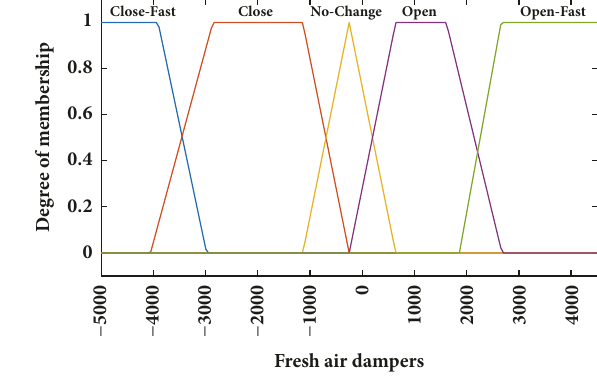
Figure 18: MFs of third output.